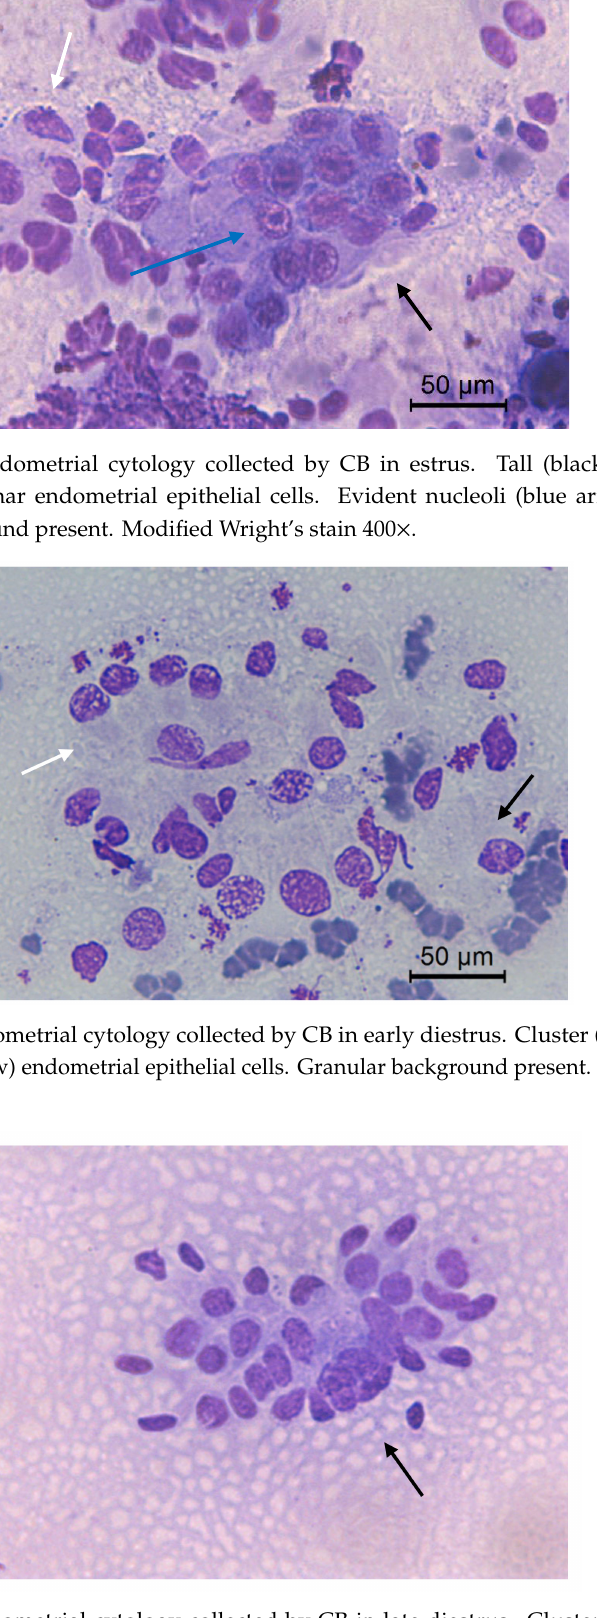
Figure 8. Jenny’s endometrial cytology collected by CB in late diestrus. Cluster, typical enlarged and foamy aspect of endometrial epithelial cells (black arrow). Dense background present. Modified Wright ’ s stain 400×.